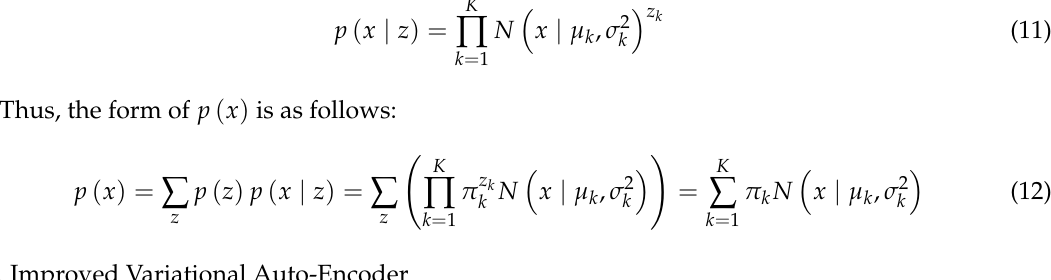
VAE algorithm. The Variational auto-encoder based on Gaussian mixtrue model (VAE-GMM) algorithm assumes that the hidden variable z is the Gaussian mixture